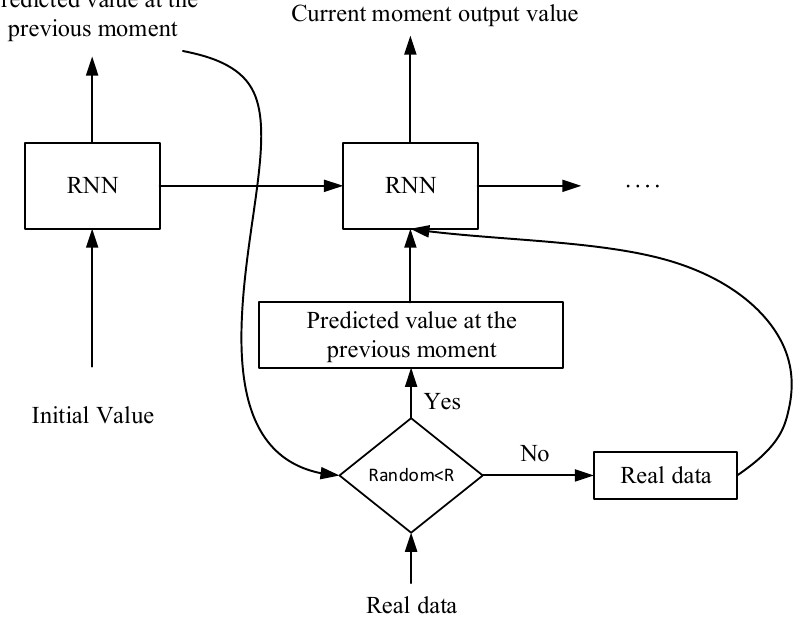
Figure 6. Teacher Forcing mechanism process.